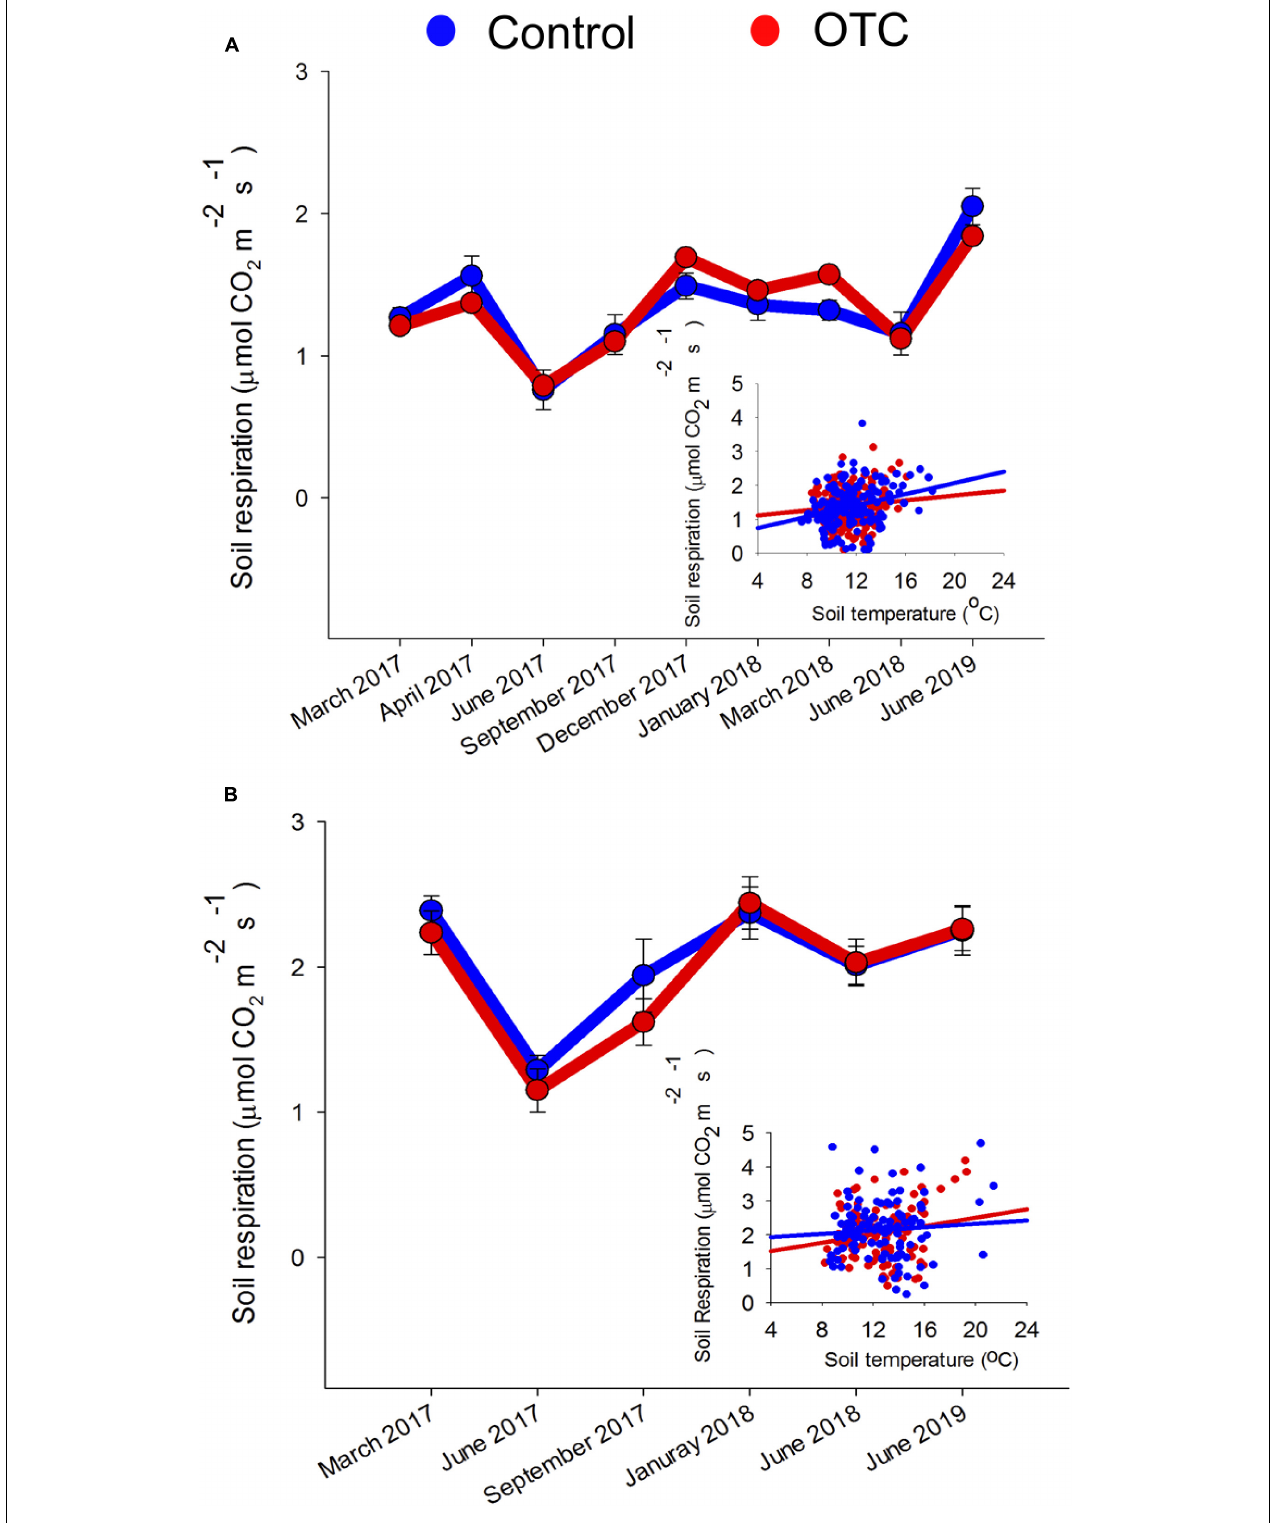
FIGURE 4 | Average CO 2 emissions from soil respiration measured inside the OTC and outside the OTC (Control) at Matarredonda (A) and Sumapaz (B) . Mean values (points) and standard errors (error bars) are given for each time and warming treatment. The inner plot shows the relationship between each soil respiration measurement and its associated soil temperature and the slope of the regression in the OTC and control plots.